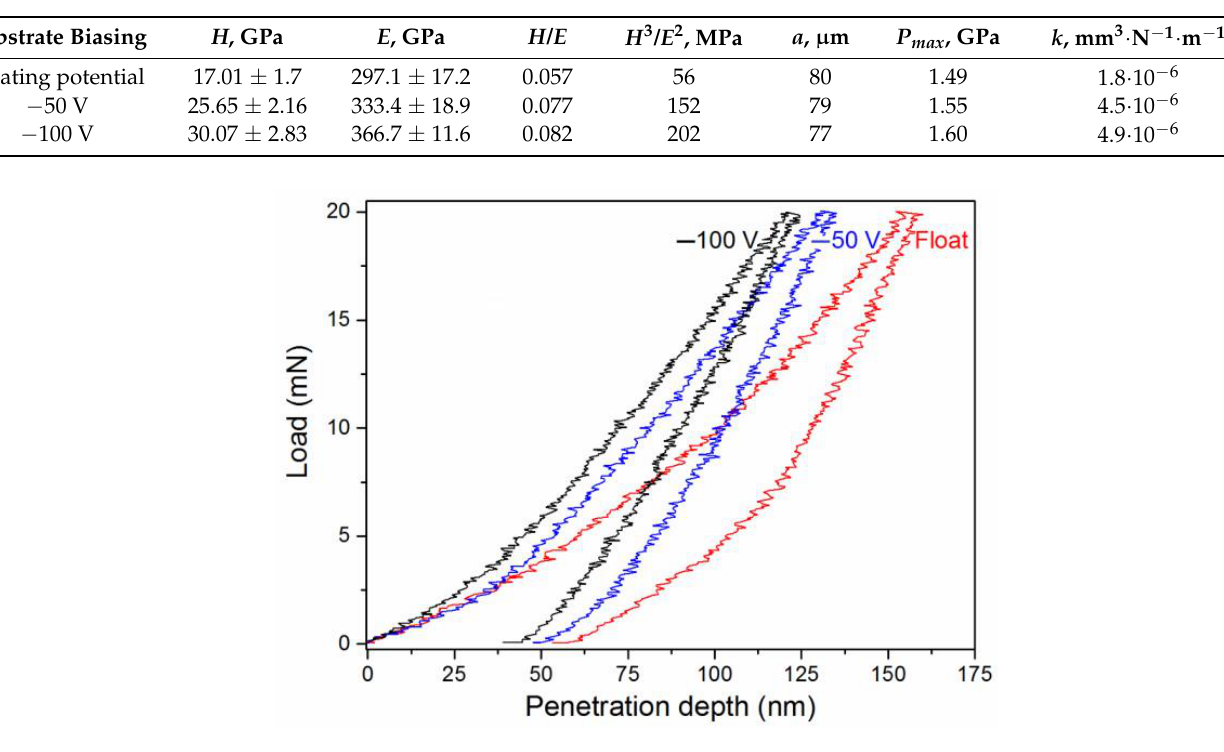
Figure 6. Wear track profiles of the TiAlN coatings deposited by the Al magnetron at 30 W of power and different substrate bias voltages. The SEM images in Figure 7 show the indentation craters formed after the Rockwell hardness test on the TiAlN-coated substrate surface. There was no coating delamination, but there were cracks near the indentation crater. Longer cracks could be observed on the substrates covered by the harder TiAlN coating, i.e., obtained at bias voltage s of −50 and −100 V . These TiN coatings showed a satisfactory adhesion strength of HF1 – HF2 ac- cording to the VDI 3198 standard [32]. Figure 7. SEM images of indentation craters formed after the adhesion testing of the TiAlN-coated substrate surface: ( a ) at the floating potential and substrate bias voltages of ( b ) − 50 V and ( c ) − 100 V.